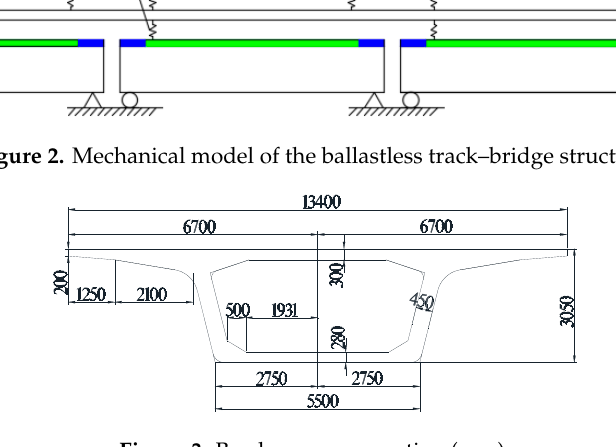
Figure 3. Box beam cross-section (mm). Table 1. Mechanical parameters of the track structure.